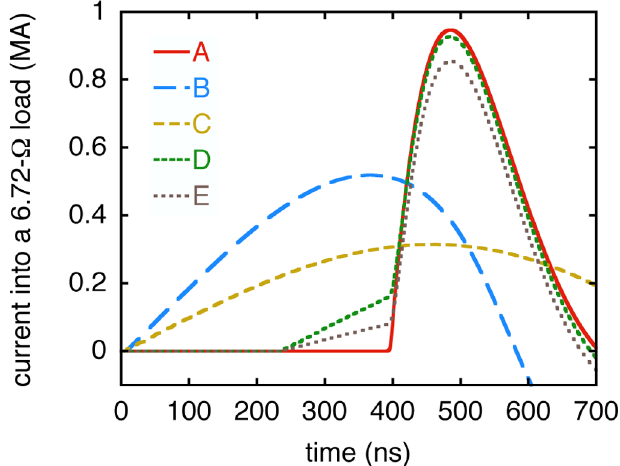
FIG. 4. (Color) Five possible current-pulse shapes that can be produced by a single 60-cavity LTD module driving a matched load. The five shapes are generated by the cavity-triggering sequences plotted by Fig. 5. For current shapes A, B, C, and D, all the cavities are charged to 200 kV. For shape E, cavities 49–60 are charged to 100 operation of the module. The cavity-triggering sequences used to generate the five shapes are plotted by Fig. 5. As indicated by Fig. 5, current-pulse-shape A (of Fig. 4)